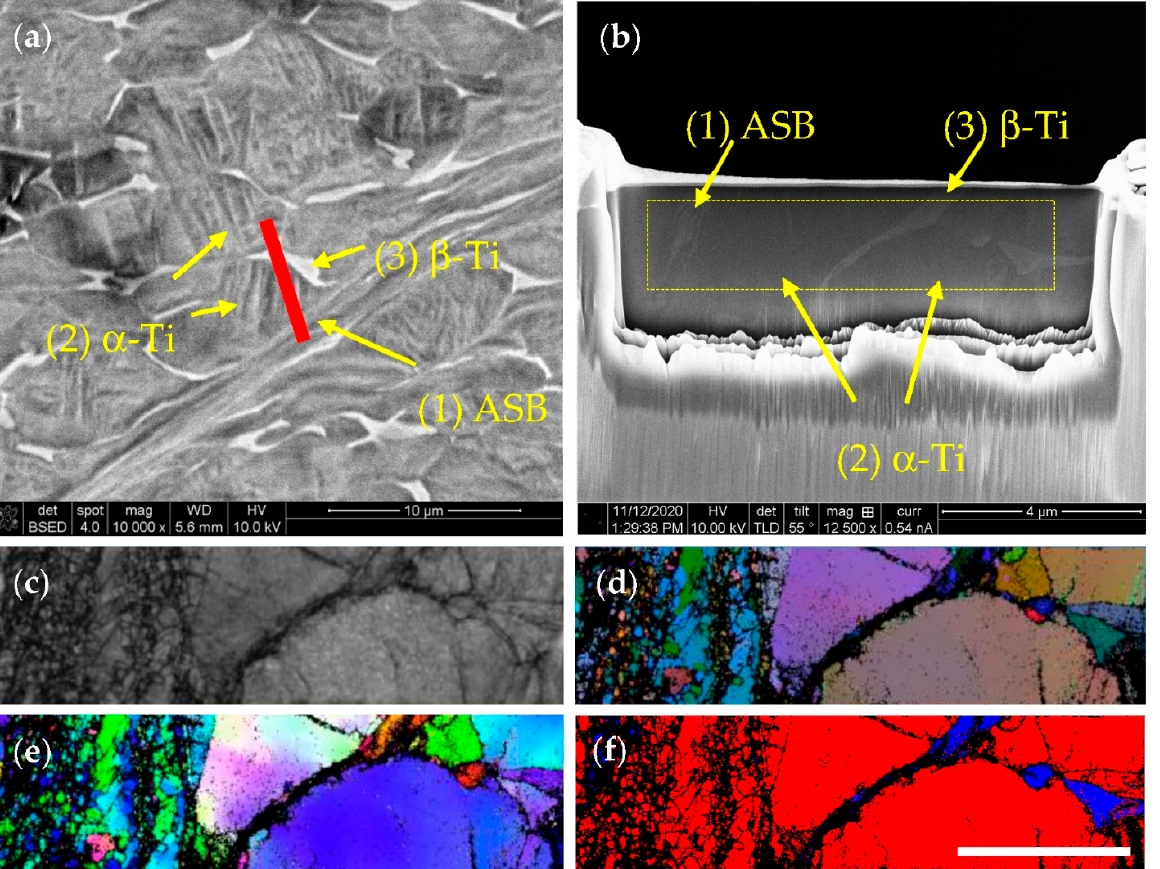
Figure 4. SEM images ( a , b ) of the area in vicinity of ASB (border between zone B and D (Figure 1a) where the lift-off sample was cut and ( c – f ) TKD framework data. The sample cut (shown with red section) crosses important structural components: a few α - and β -Ti grains (readily distinguished using the backscattered electrons contrast) and the ASB area labeled in ( a , b ). The image of the sample showing all structural elements within the lift-off region ( b ) and the TKD analyzed area highlighted with yellow-dashed rectangular. PQM ( c ); grains map in random color ( d ); IPF map €; phase map showing α -Ti in red and β -Ti in blue ( f ). The scale bar in ( f ) is 2.5 μ m.